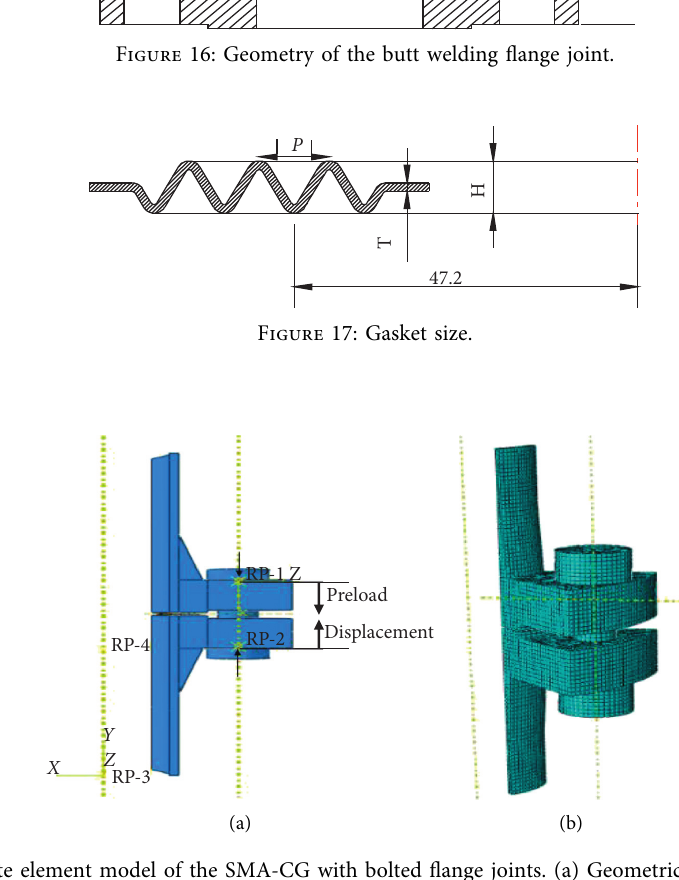
Figure 18: The finite element model of the SMA-CG with bolted flange joints. (a) Geometric model. (b) Mesh